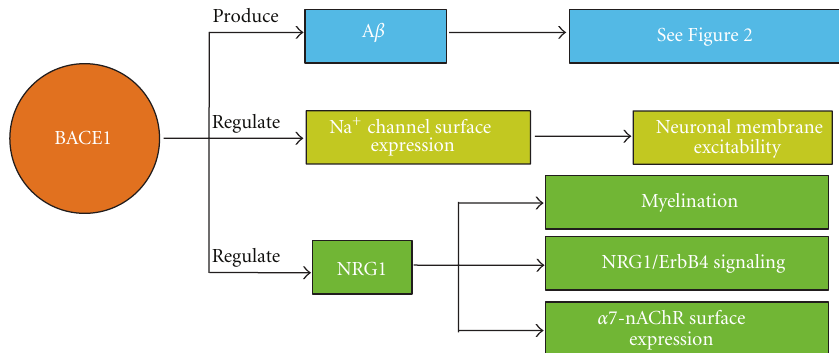
Figure 3: The roles of BACE1 in synaptic function. Besides cleaving APP to produce A β peptides, BACE1 has been found to have other substrates. It can process the β 2 subunit of the voltage-gated sodium (Na + ) channels, which can regulate Na + channel surface expression and in turn modulate neuronal excitability. In addition, BACE1 can cleave NRG1, which plays a crucial role in myelination and NRG1/ErbB4 signaling. Recently, it has been showed that NRG1 can regulate cell surface expression of α 7-nAChRs, which can also a ff ect synaptic